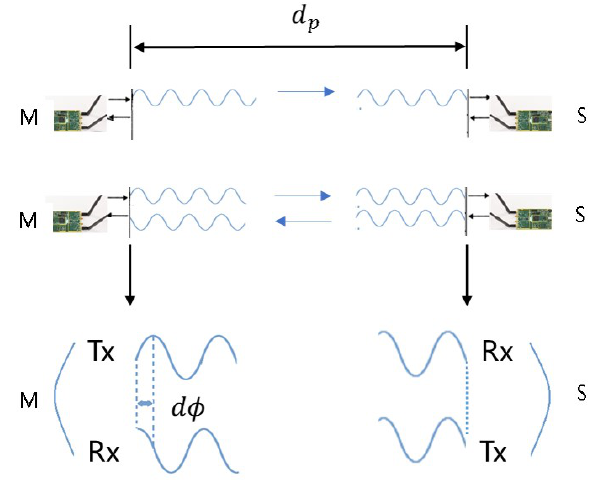
Figure 1. PRG range finding